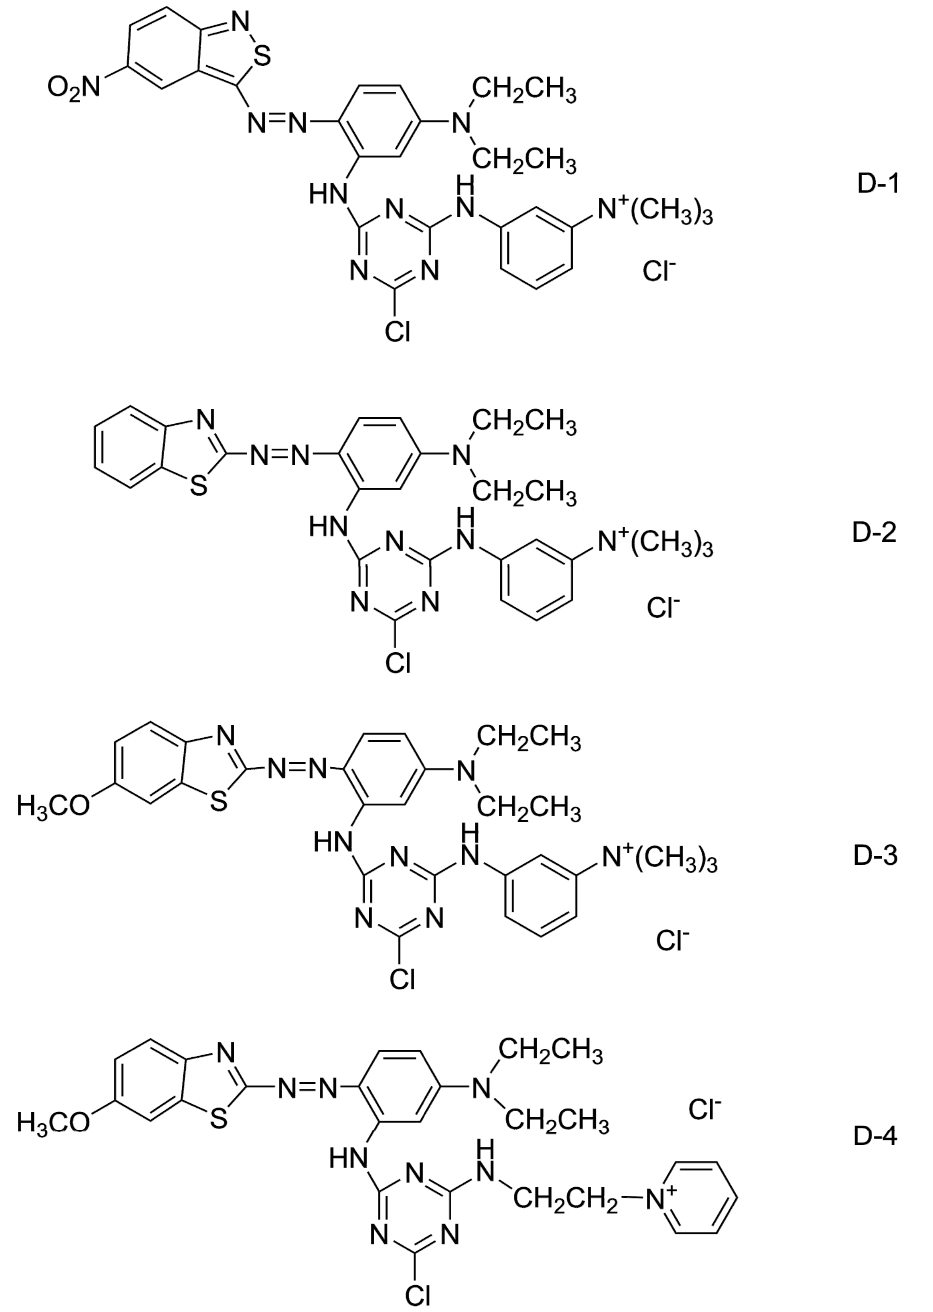
Figure 2. Structures of the synthesized heterocyclic reactive dyes.